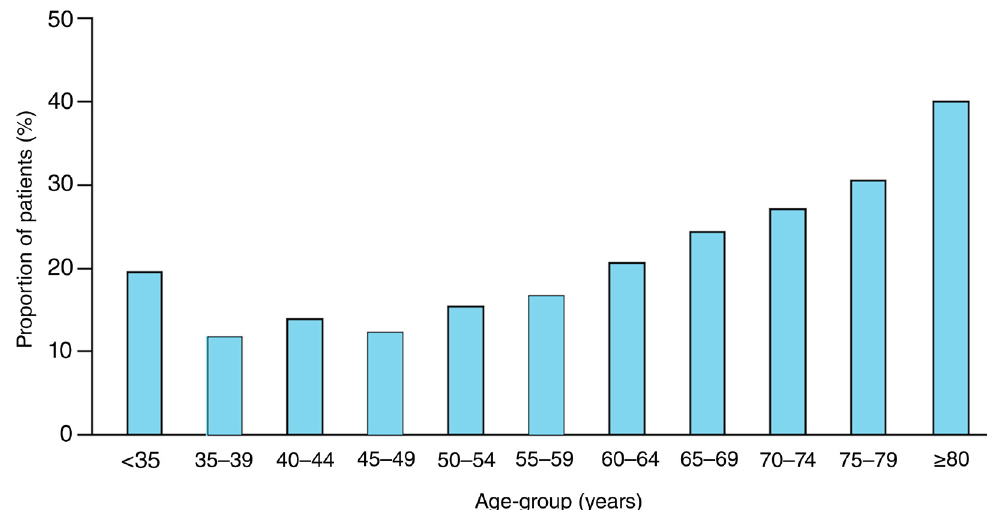
Figure 4. Plasma total homocysteine by age group in vascular patients. Among 2,372 patients referred to our stroke prevention clinic or vascular prevention clinic, the proportion with concentrations of plasma total homocysteine of 14 μmol/L or more increased significantly with age. Reproduced by permission of Elsevier from